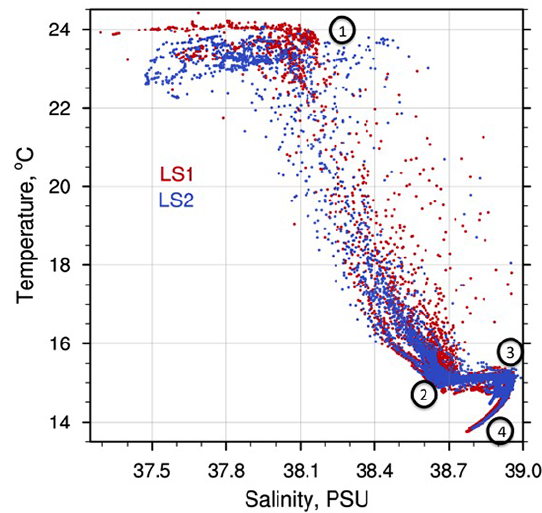
Figure 5. T-S diagram for all the LS1–LS2 profiles, covering the depths of 1–900m (the deepest point is in the central trench of the Gulf of Taranto, see Fig. 1). Numbers refer to the four water mass types found in the profiles and discussed in the